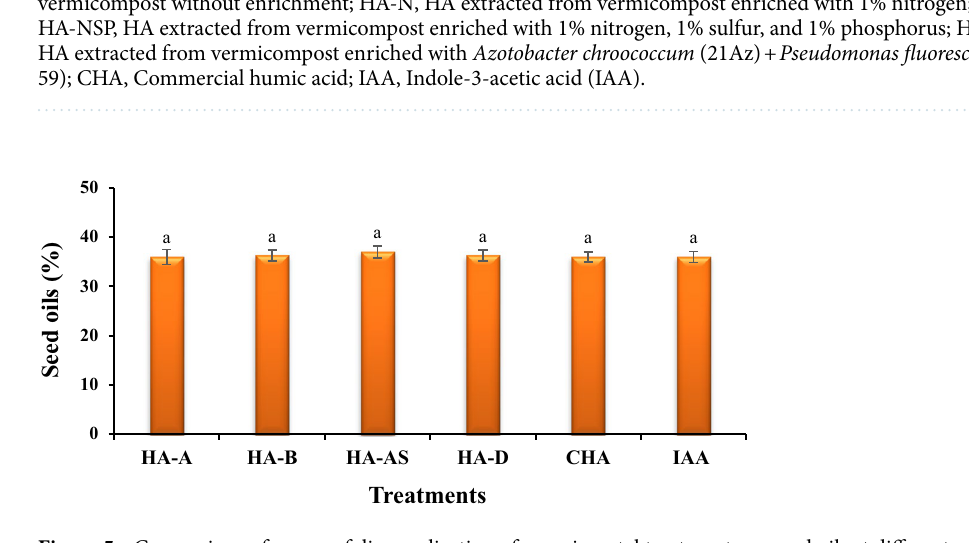
Figure 5. Comparison of average foliar application of experimental treatments on seed oils at different treatments. Different letters show significant difference at p ≤ 0.05 by Duncan multiple range test. HA, HA extracted from vermicompost without enrichment; HA-N, HA extracted from vermicompost enriched with 1% nitrogen; HA-NSP, HA extracted from vermicompost enriched with 1% nitrogen, 1% sulfur, and 1% phosphorus; HA-AS, HA extracted from vermicompost enriched with Azotobacter chroococcum (21Az) + Pseudomonas fluorescens (Ps 59); CHA, Commercial humic acid; IAA, Indole-3-acetic acid